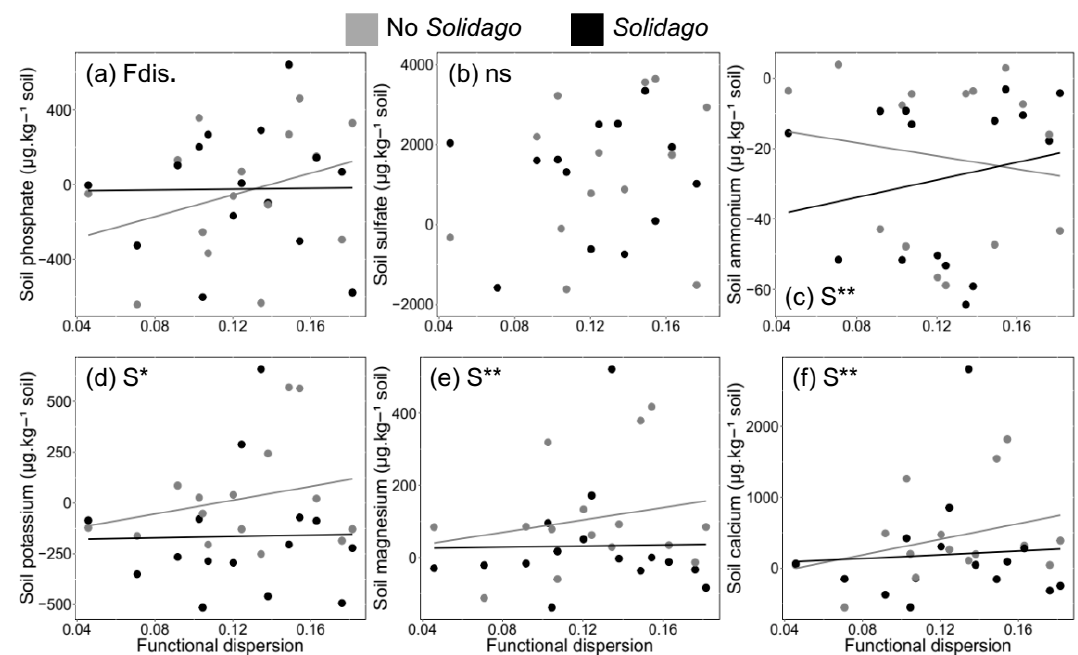
Figure 4. Effects of functional dispersion (Fdis) and Solidago gigantea (S) on the macronutrients measured in the soil of the grassland communities . Figures show six macronutrients that are important for plant growth and are directly controlled by plants: ( a ), phosphate; ( b ), sulfate; ( c ), ammonium; ( d ), potassium; ( e ), magnesium; and ( f ), calcium. For the dependent variables, chi-squared values are presented in the text (** p ≤ 0.01; * p ≤ 0.05; p ≤ 0.10; ns p > 0.10).